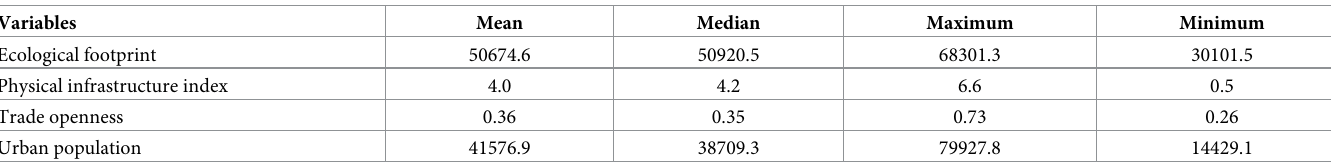
Table 3. Descriptive statistics of the data